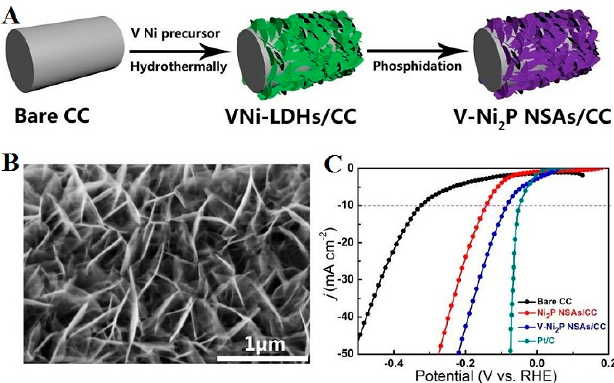
Figure 6. ( A ) Schematic illustration of synthesis of the V-Ni 2 P NSAs loaded on carbon cloth. ( B ) SEM images of V-Ni 2 P NSAs/CC. ( C ) Polarization curves of bare CC, Ni 2 P NSAs/CC, V-Ni 2 P NSAs/CC and Pt/C (reprinted with permission from ref [47]. Copyright © 2019, Royal Society of Chemistry).